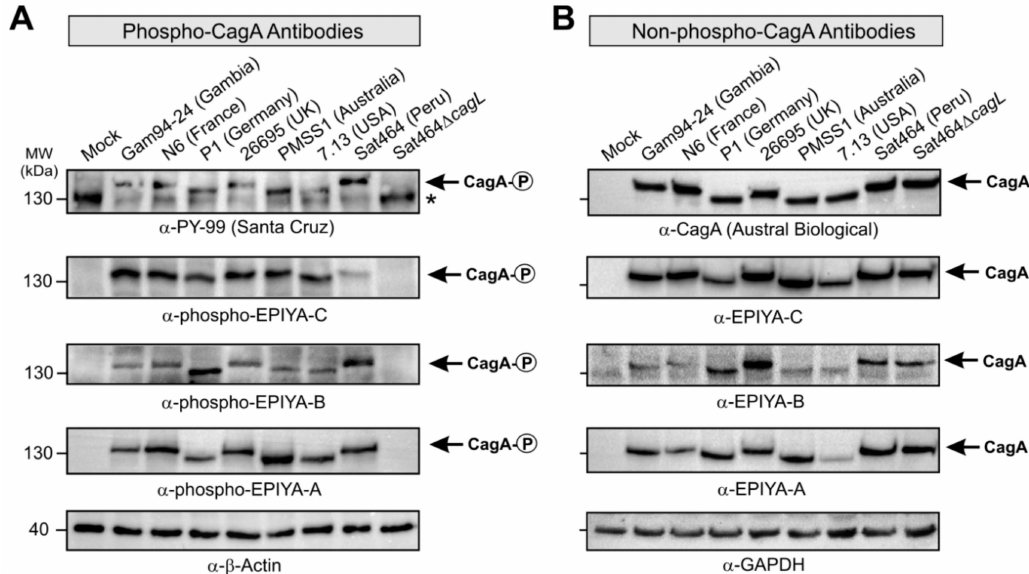
Figure 5. Phosphorylation of CagA EPIYA-motifs during H. pylori infection was investigated using specific α -phosphotyrosine antibodies. AGS cells were infected for 6 h with CagA-expressing H. pylori strains from countries of five continents as indicated. The samples in Figure 3 were collected after photographing and phenotype quantification. Phosphorylation of CagA was examined using the indicated ( A ) phospho-specific and ( B ) non-phospho-specific EPIYA antibodies with α -PY-99 (Santa Cruz) antibodies as control. Loading of equal amounts of CagA in each sample has been approved by a commercial α -CagA antibody (Austral Biologicals). The phospho-CagA bands of di ff erent sizes (arrows) as well as a set of tyrosine-phosphorylated host cell proteins (asterisk) are marked. Three independent experiments were performed with similar results. The corresponding uncropped files are shown in Supplementary Figures S1 and S2, respectively, and the statistics are shown in Supplementary Figure